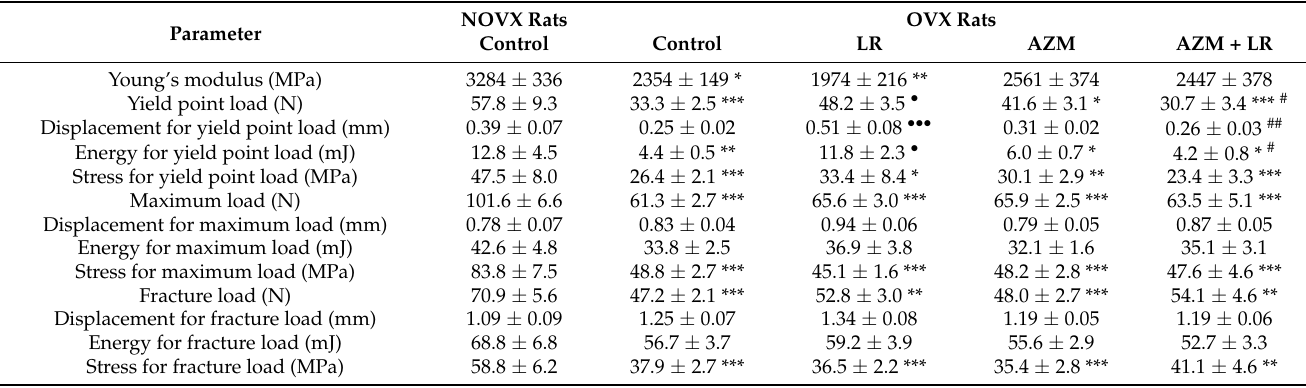
Table 4. Effect of azithromycin (AZM) and/or Lactobacillus rhamnosus (LR) on mechanical properties of the proximal tibial metaphysis in ovariectomized rats.